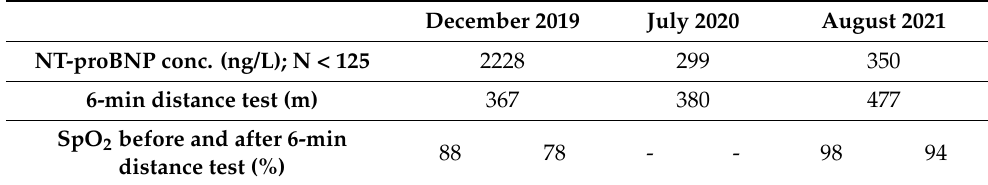
Table 1. Clinical and laboratory results before and after surgical ASD treatment.